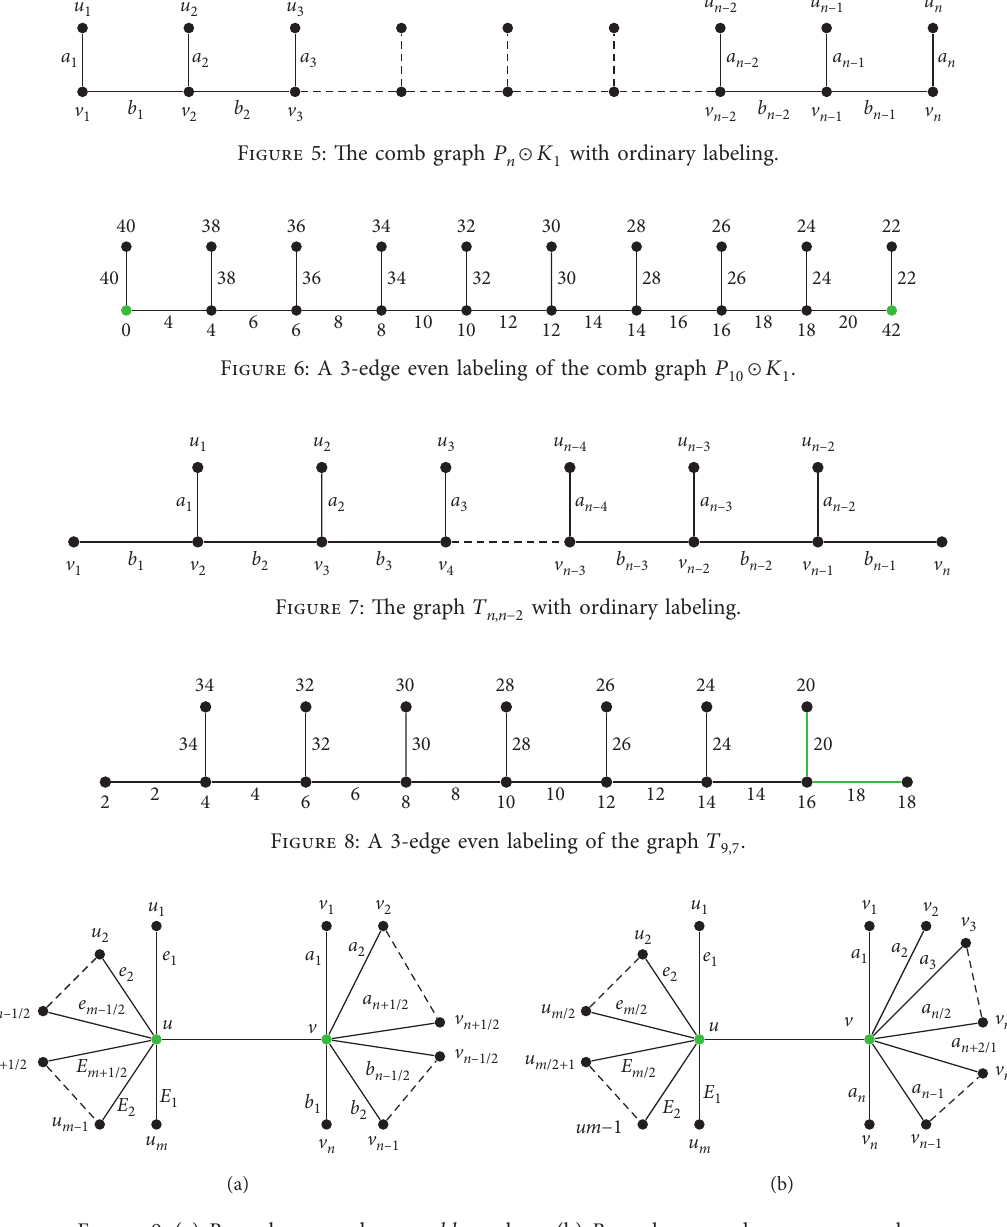
m and n are even m,n when